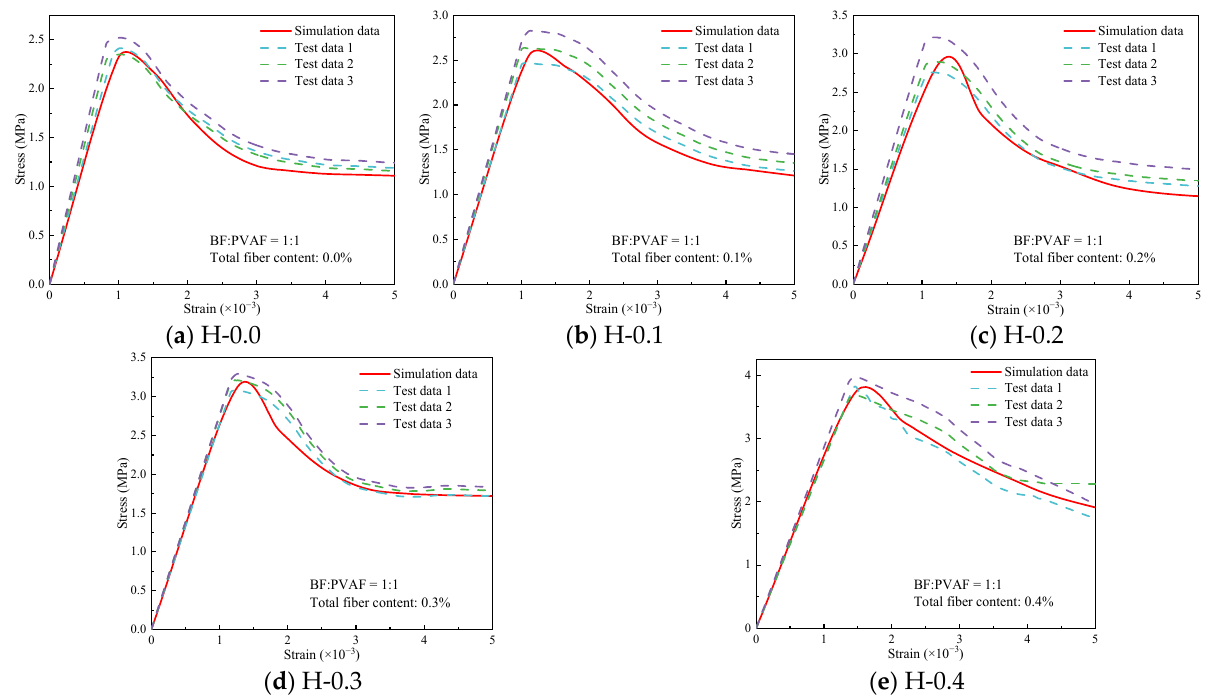
Figure 30. Comparison of splitting tensile stress-strain curves of hybrid fiber-reinforced LHPCC (test and simulation curves).